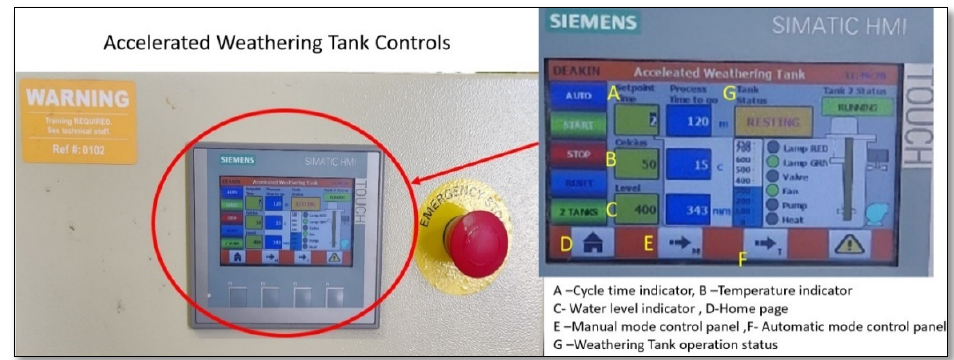
Figure 4. Automated tidal cycle settings.